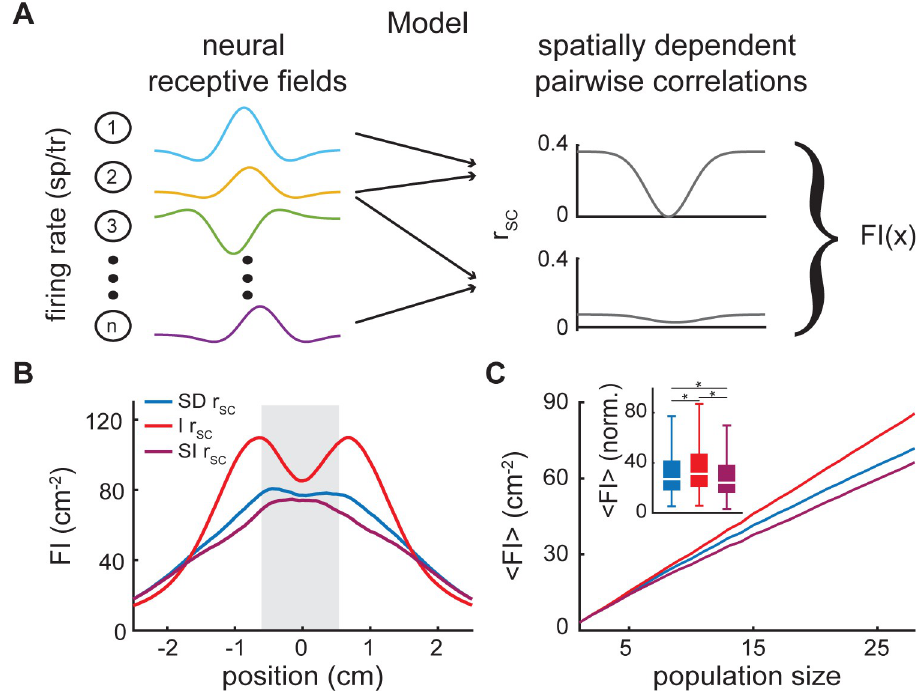
Fig 7. Modeling receptive field heterogeneities and spatially dependent spike-count correlations. (A) Schematic of the model in which modeled neural receptive fields (left, colored curves) and spatially dependent pairwise spike-count correlations (right, grey curves) are used to calculate the spatially dependent Fisher information. (B) Fisher information visualized as a function of stimulus position for spatially dependent (SD: blue), independent (I: red) and spatially independent correlation scenarios (SI: purple). (C) Fisher information ( < FI > ) as a function of neural population size (averaged between -0.5 and 0.5 cm). Though quite small, the shaded error bars indicate the SEM in (B & C). Inset: Fisher information at the neural population size of 28 neurons, normalized by the Fisher information at a population size of one neuron, is significantly different for the three correlation scenarios: spatially dependent, independent, and spatially independent (Kruskal-Wallis: p = 8 � 10 − 17 ; SD—I: p = 3.3 � 10 − 6 ; SD—SI: p = 6.2 � 10 − 4 ; I— SI: p = 2.7 � 10 − 17 ). “ � ” indicates statistical significance.